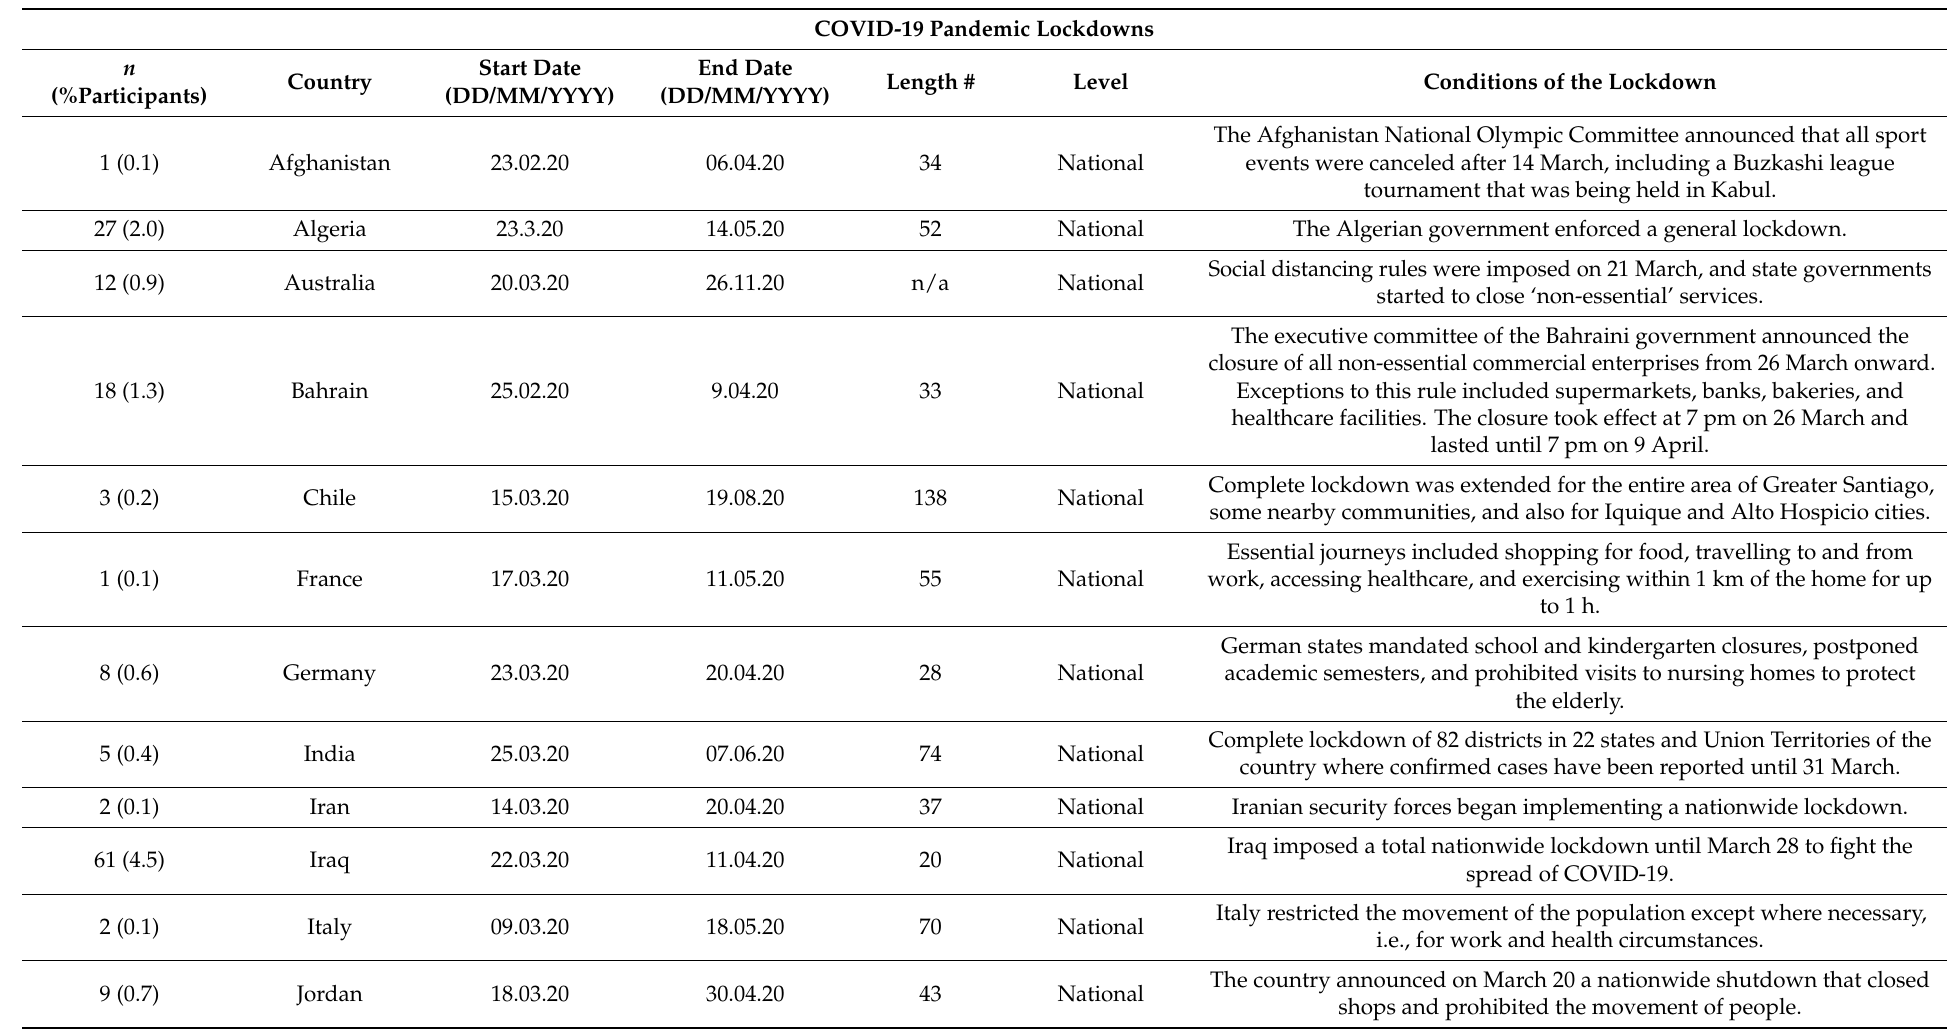
Table 4. Description of the conditions of lockdown in the different countries of the participants during the first